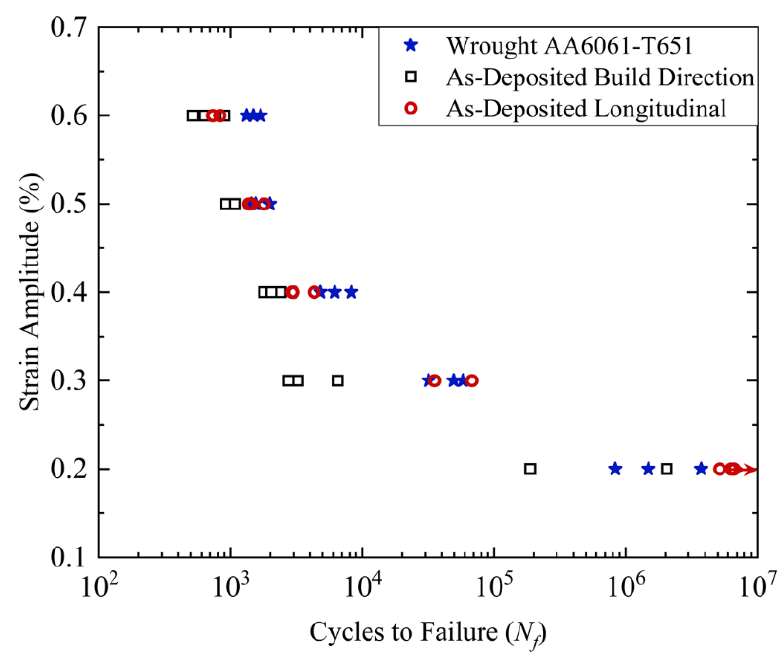
Figure 5. Strain amplitude versus cycles to failure plot of the AA6061-T651 feedstock, AA6061 AFS-D as-deposited longitudinal direction, and AA6061 AFS-D as-deposited build direction.